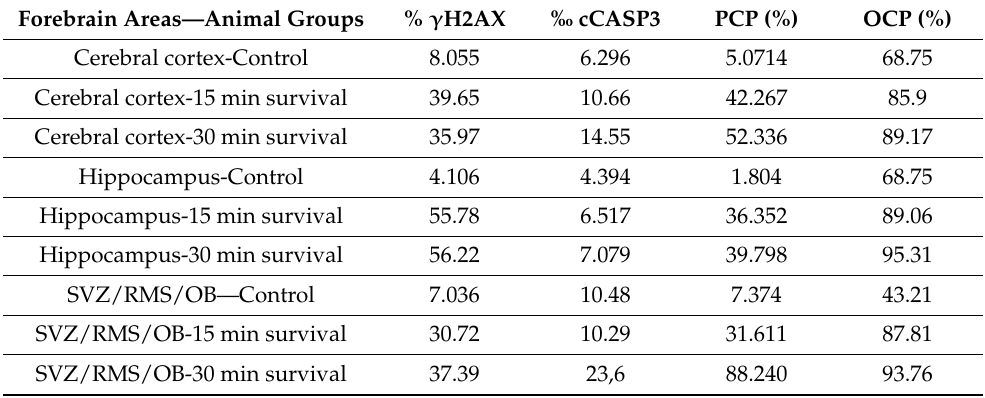
Table 1. Predicted co-labeling percentage (PCP) and observed co-labeling percentage (OCP) of γ H2AX+cCASP3 immunoreactive nuclei in the forebrain areas of control and irradiated mice. Note that data for cCASP3 are expressed as per mil numbers of cells. Therefore, calculation of PCP is made using the following formula: % γ H2AX × ‰ cCASP3 based on the joint probability of event 10 A (positivity for γ H2AX) and event B (positivity for cCASP3) and considering the two events independent. In this case, computing is made by simply multiplying the probabilities of the two events: P ( A ∩ B ) = P ( A ) × P ( B )